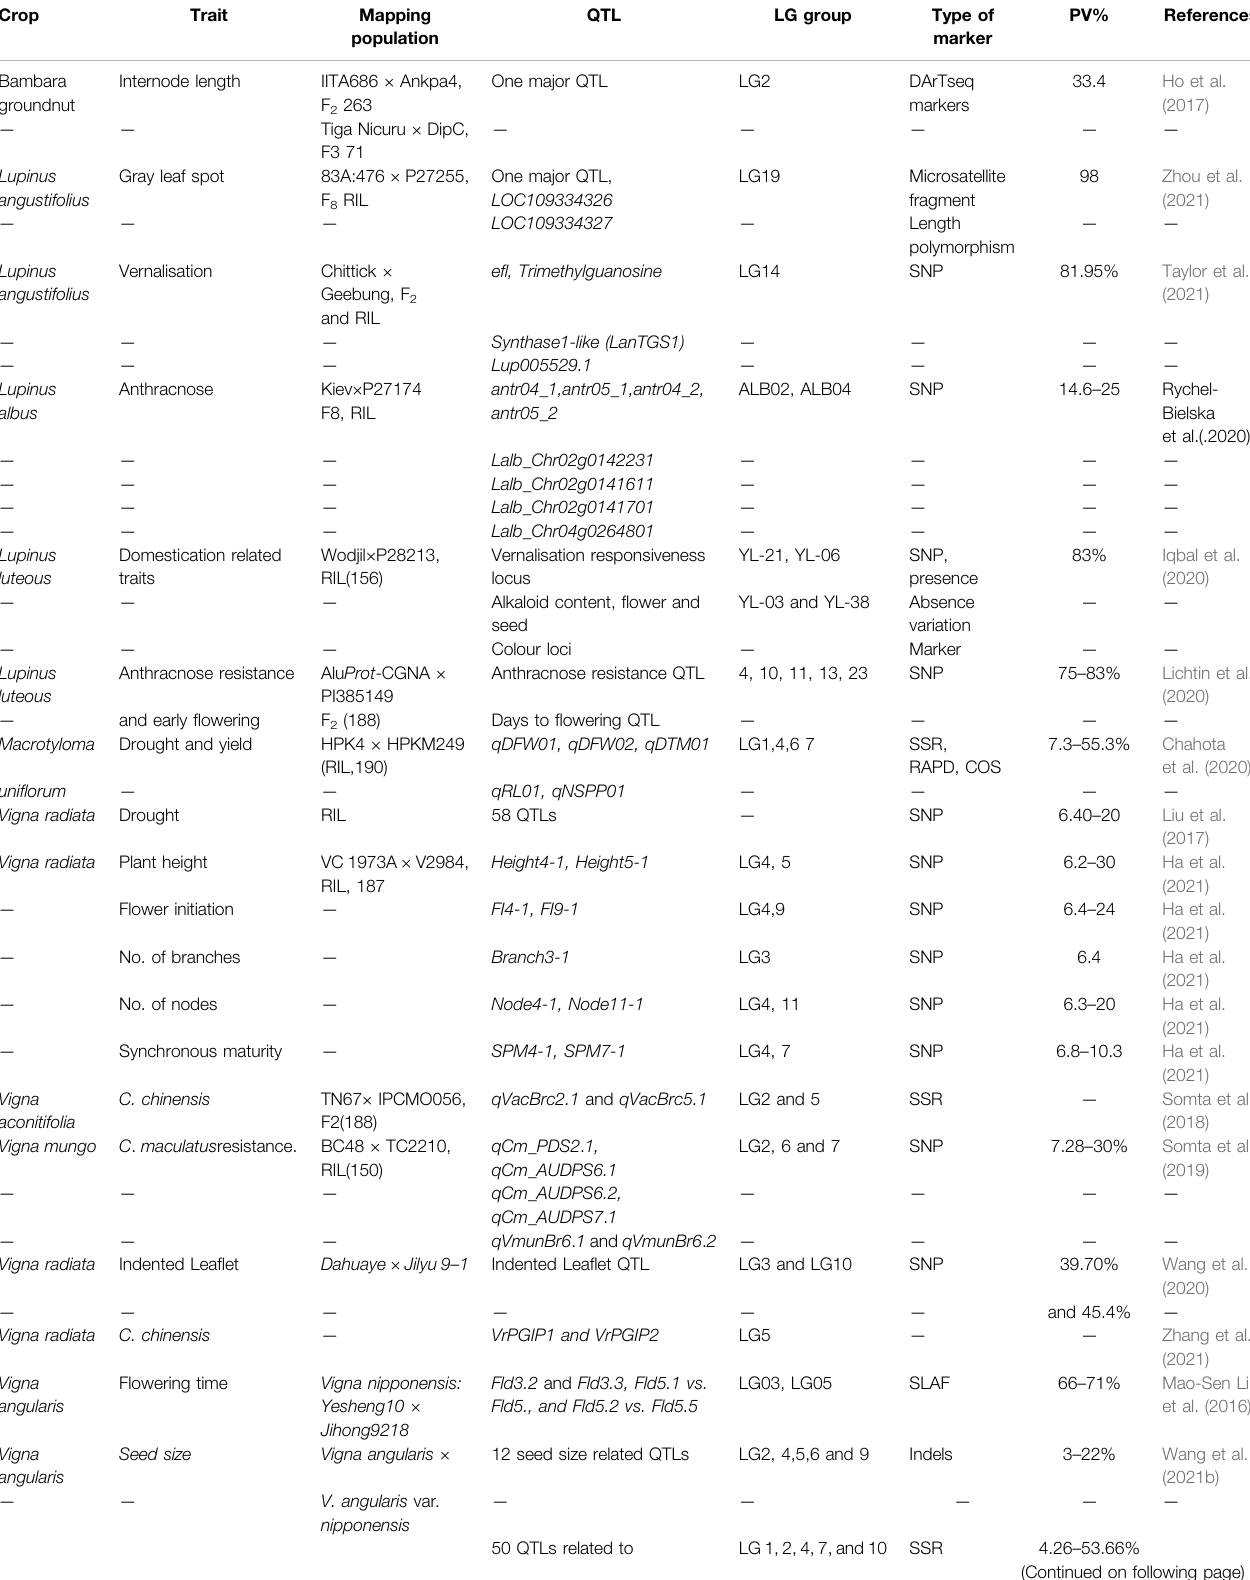
TABLE 4 | List of selected QTLs identi fi ed in various underutilised legume crops. Crop